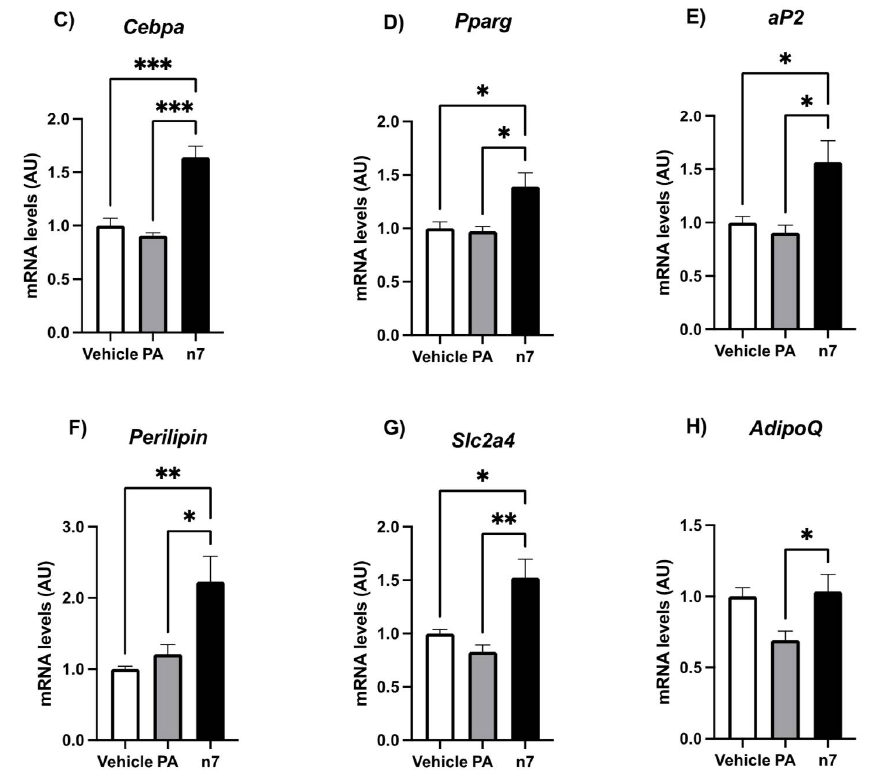
Figure 2. Effects of palmitoleic acid on 3T3-L1 cell proliferation and differentiation. ( A ) Preadipocytes proliferation determined by MTT assay. Cells were plated into 96-well plates at a density of 3 × 10 3 cells/100 µ L per well. These cells were then cultured in media with vehicle, palmitic (PA, 100 μM) or palmitoleic acid (n7, 100 μM) for 24 h. ( B ) Lipid accumulation determined by oil red O staining and spectrophotometry. Images were obtained with a phase-contrast microscope at low magnification −20x. mRNA levels of adipogenic markers: Cebpa ( C ), Pparg ( D ), aP2 ( E ), Perilipin ( F ), Scl2a4 ( G ) and AdipoQ ( H ). Values of mRNA were expressed as arbitrary units (AU) in relation to the control and corrected by the expression of the constitutive gene 36B4 . In B-H, experiments were performed in differentiated 3T3-L1 adipocytes (day 6) treated with the fatty acids on day 0 (with the differentiation induction medium) and maintained until the end. Values are mean ± SEM of six samples from two independent experiments. * p < 0.05, ** p < 0.001, *** p < 0.0001 or **** p < 0.00001 vs.